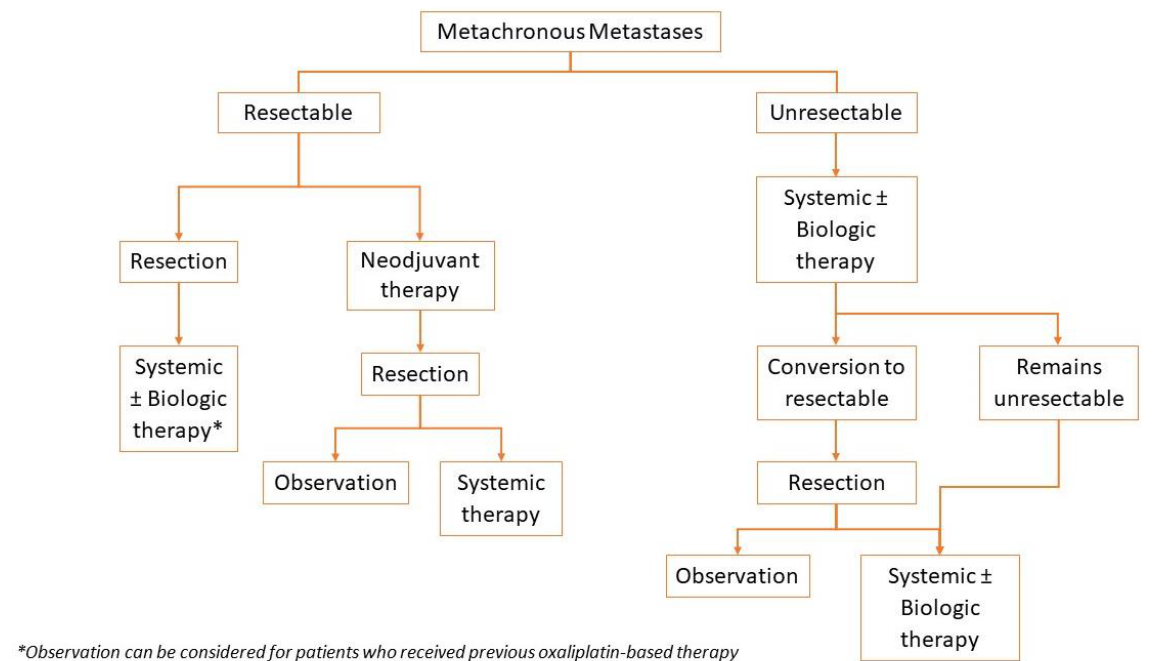
Figure 3. Treatment Algorithm for Metastatic Metachronous Adenocarcinoma of the Colon and Rec- tum.